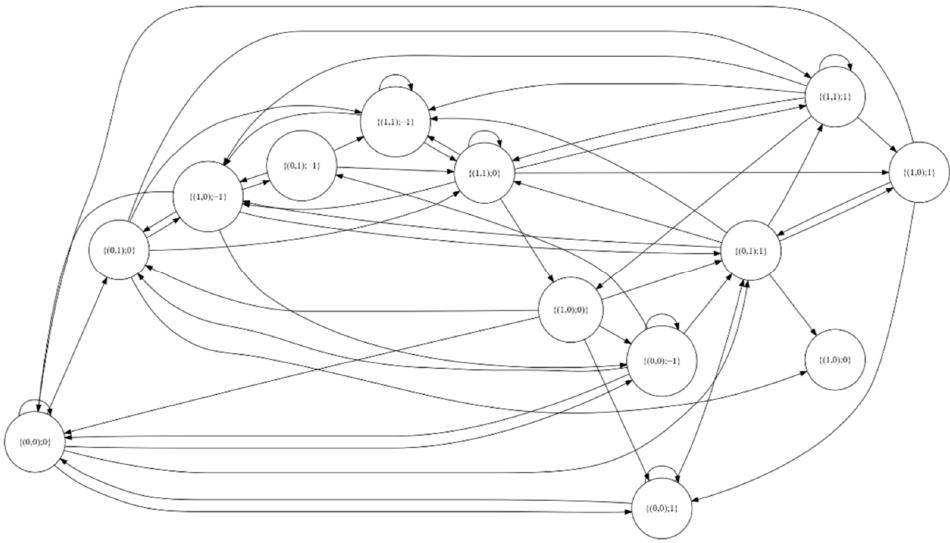
Figure 3. Graph of the change process for SMBMA (25,2,4,0.55) model of AUD/NZD. Source: